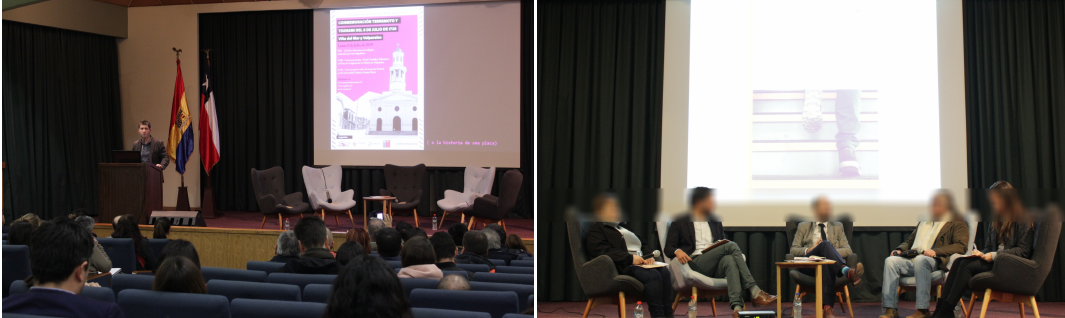
Figure 9. Photos of the round table discussions at UTFSM. Refer to the meeting’s introductory video with views of Valparaíso (shown in video